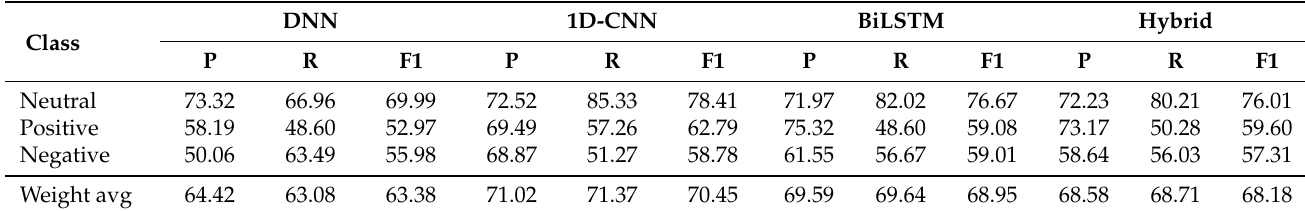
Table 8. Performance of deep neural models and the baseline using fastText.